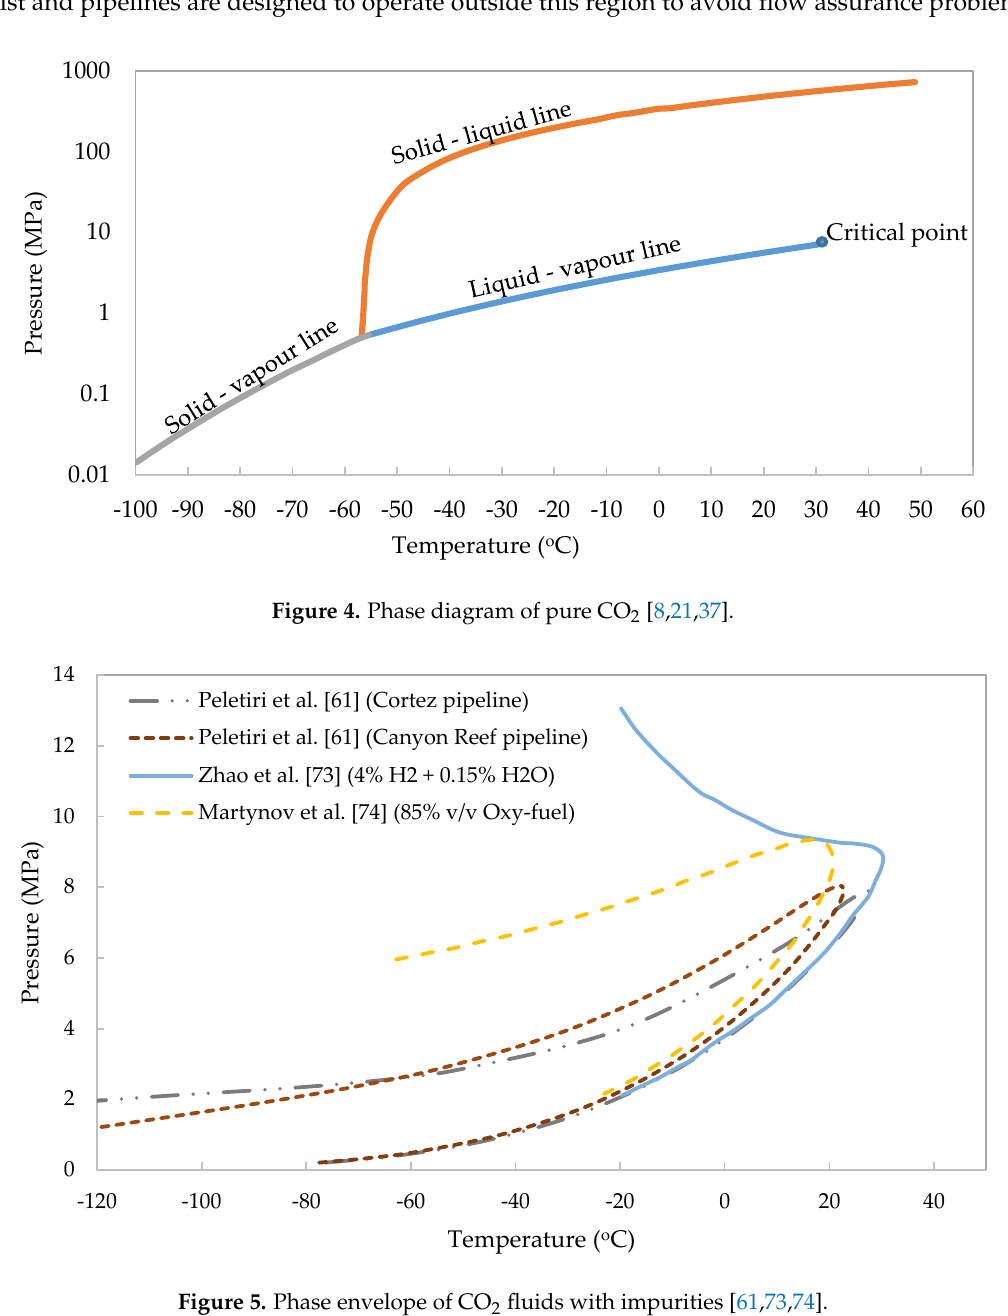
Figure 5. Phase envelope of CO 2 fluids with impurities [61,73,74].